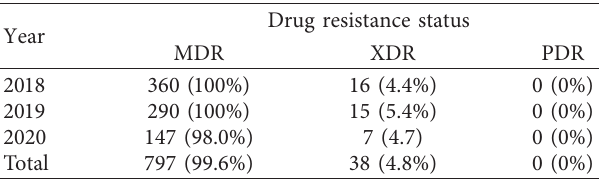
Figure 2: Multidrug resistance pattern of bacterial isolates from Bolgatanga Regional Hospital, Ghana, January 2018–July 2020. Table 3: Drug resistance status of bacteria from Bolgatanga Re- gional Hospital stratified by years.